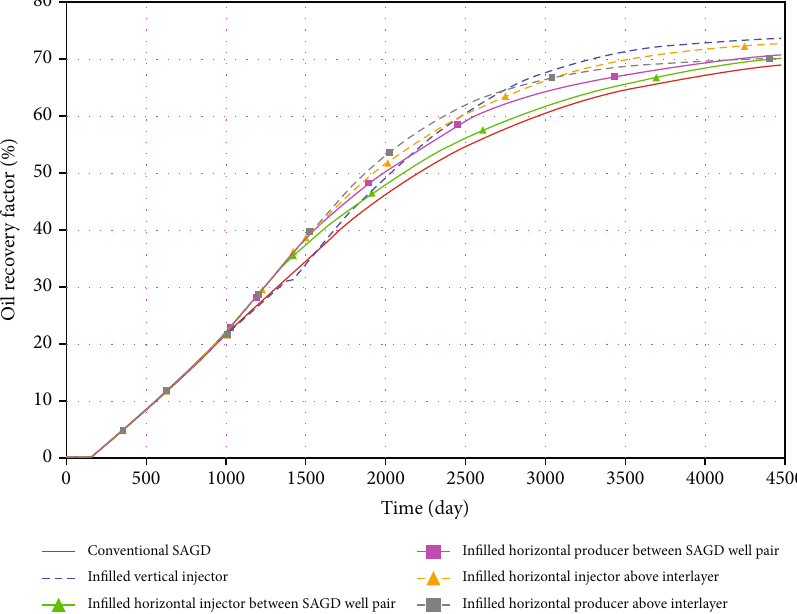
Figure 10: Production characteristics of the di ff erent schemes for model